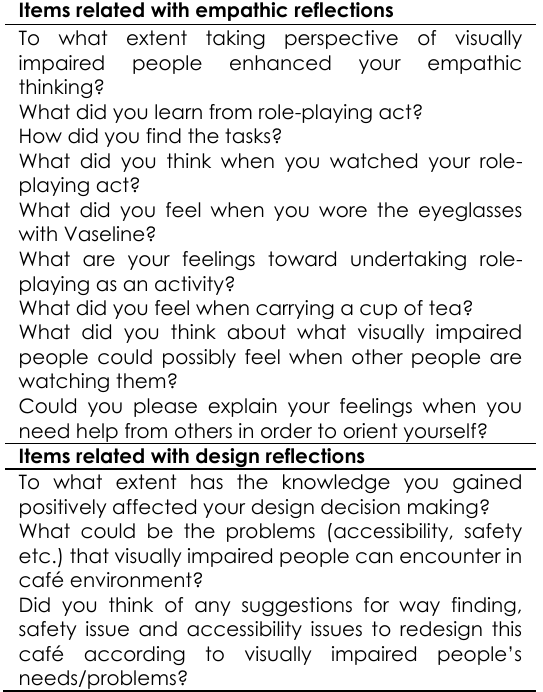
Table 1. Semi-Structured Interview